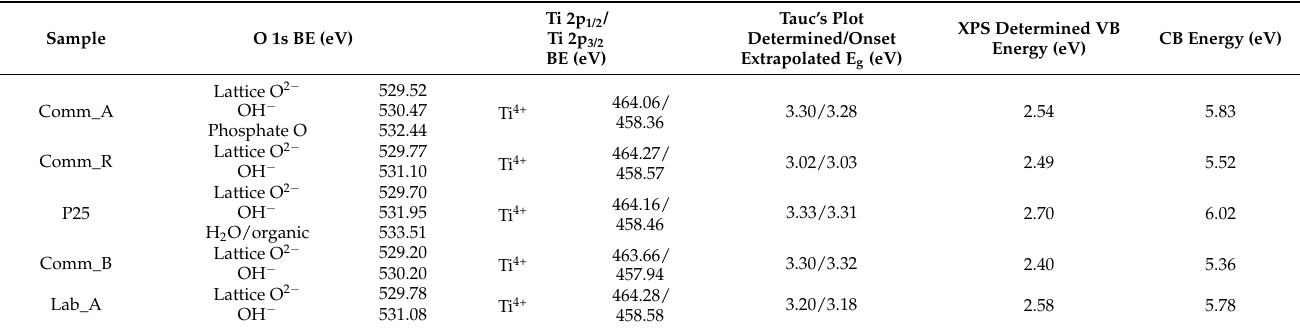
Table 2. Results of XPS analysis concerning the surface chemical composition and the curve-fitting of the Ti 2p and O1s lines; band-gap values, as obtained from DR-UV-Vis spectra by applying the Tauc’s plot method and by extrapolation of the absorption onset; VB value as obtained by XPS analysis and calculated CB